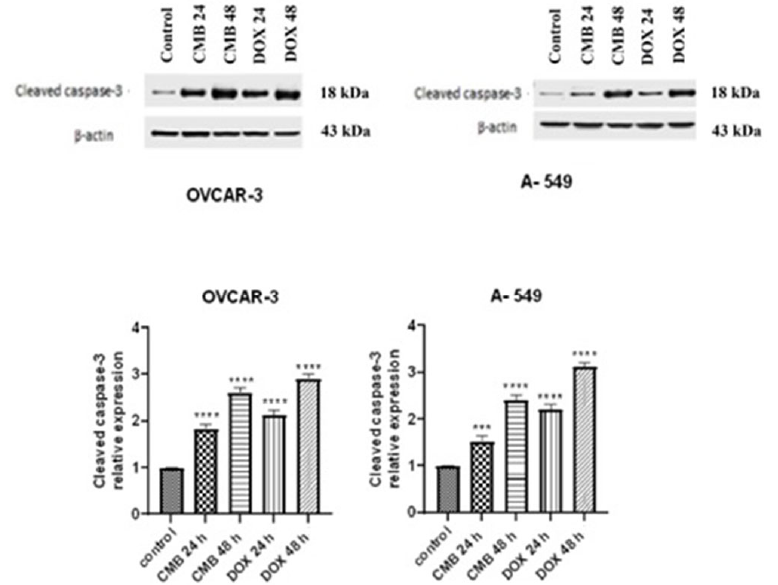
Figure 7. Western blots of active caspase-3 levels in OVCAR-3 and A-549 cells, respectively, incubated with CMB and doxorubicin at IC 50 values for 24 h or 48 h. Means and SE were calculated from three independent experiments. Statistically significant results compared to untreated control were presented as: *** p < 0.001; **** p < 0.0001.